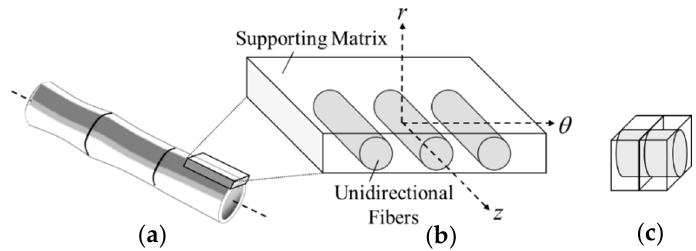
Figure 3. ( a ) Axially strengthened bamboo; ( b ) schematic representation of bamboo lamina and ( c ) transverse isotropy model.